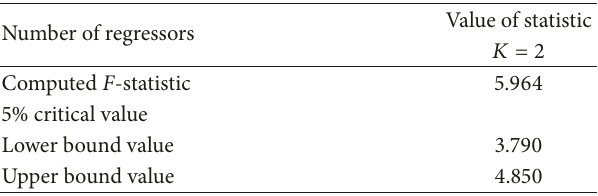
Table 3: Testing for the existence of level relationship among variables in the ARDL